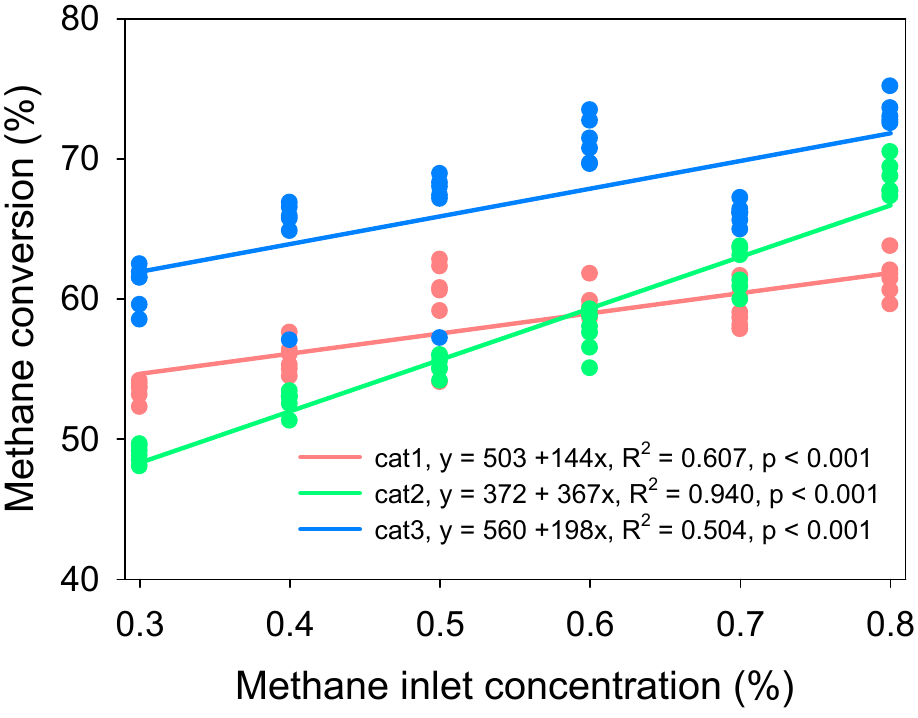
Figure 3. Correlation of methane inlet concentration and methane conversion. Start-up conditions: switch frequency: 5 min, reaction temperature: 800 °C, gas flow: 1.2 m 3 /h.